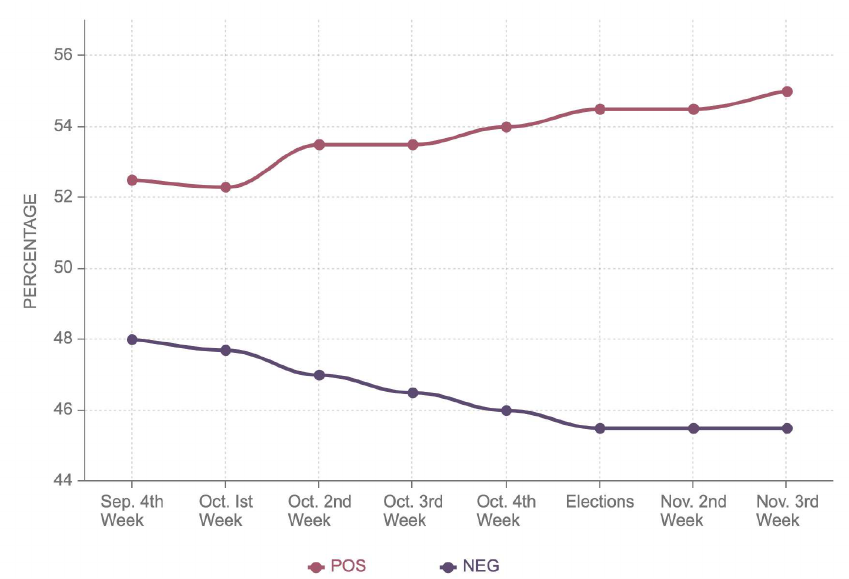
Figure 9. Graphs of positive and negative sentiments of Joe Biden in Georgia.